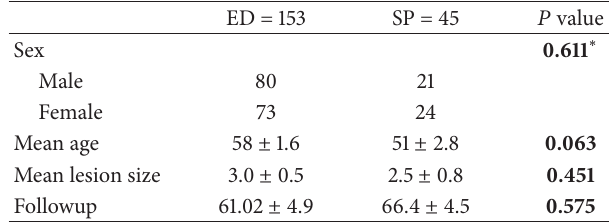
Table 1: Demographic characteristics of the study